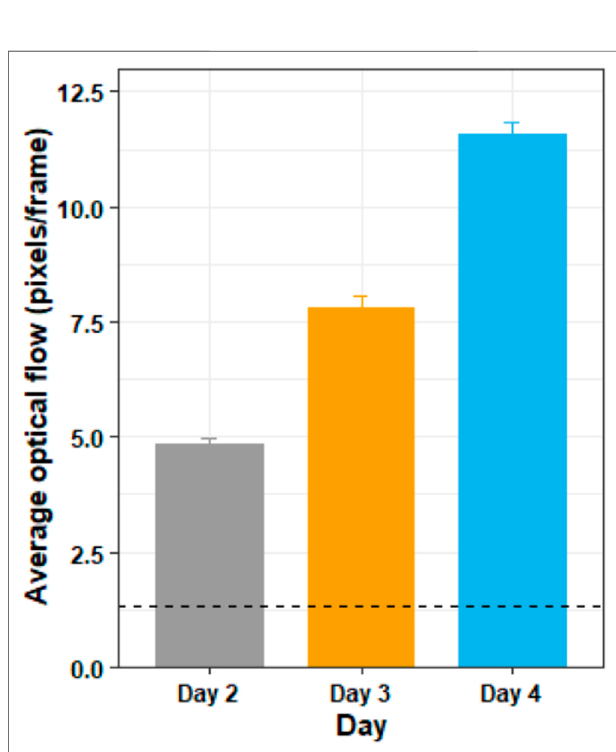
FIGURE 8 | The average optic fl ow magnitude by day for the training days.Thehorizontaldottedlineshowstheaverageoptic fl owmagnitudeofthe two testing days (days 1 and 5) for comparison. The fi gure shows mean and standard deviation.